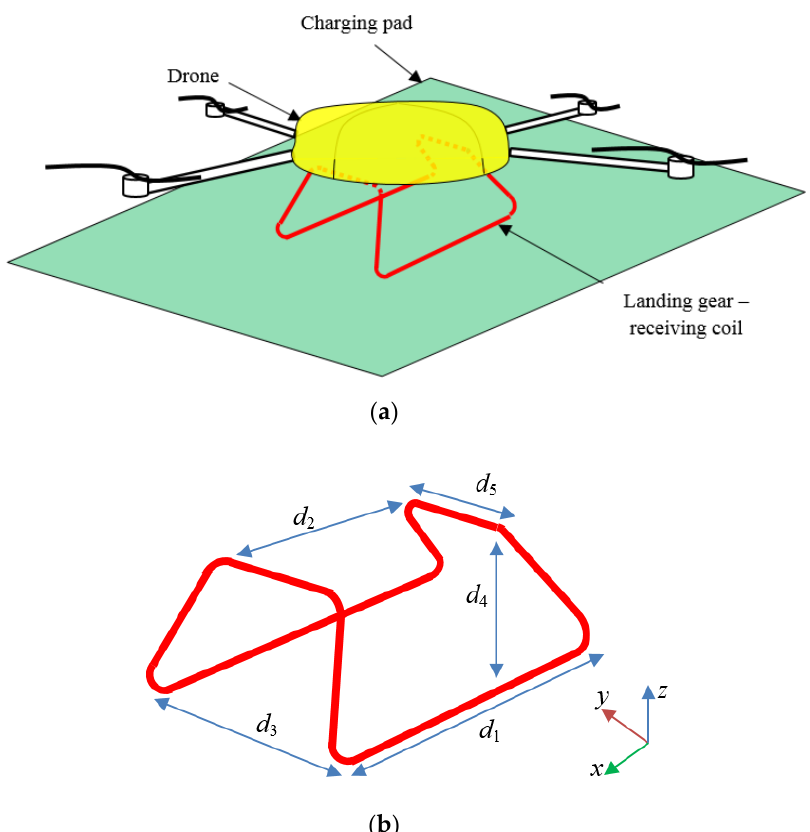
Figure 3. System configuration for drone wireless charging ( a ) and landing gear dimensions ( b ).